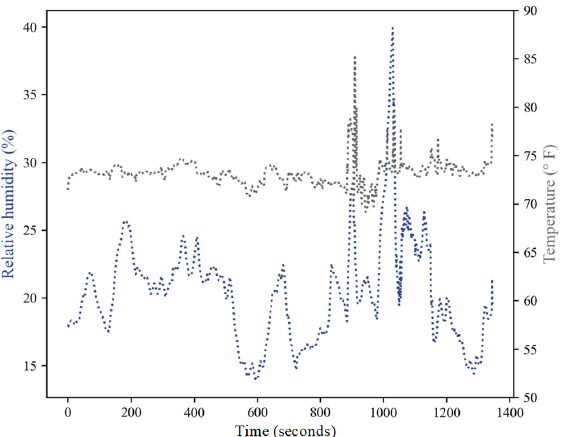
Figure 7. Relative humidity and temperature readings over time from the clay embedded sensor measured at 141.7 m. measured at 141.7